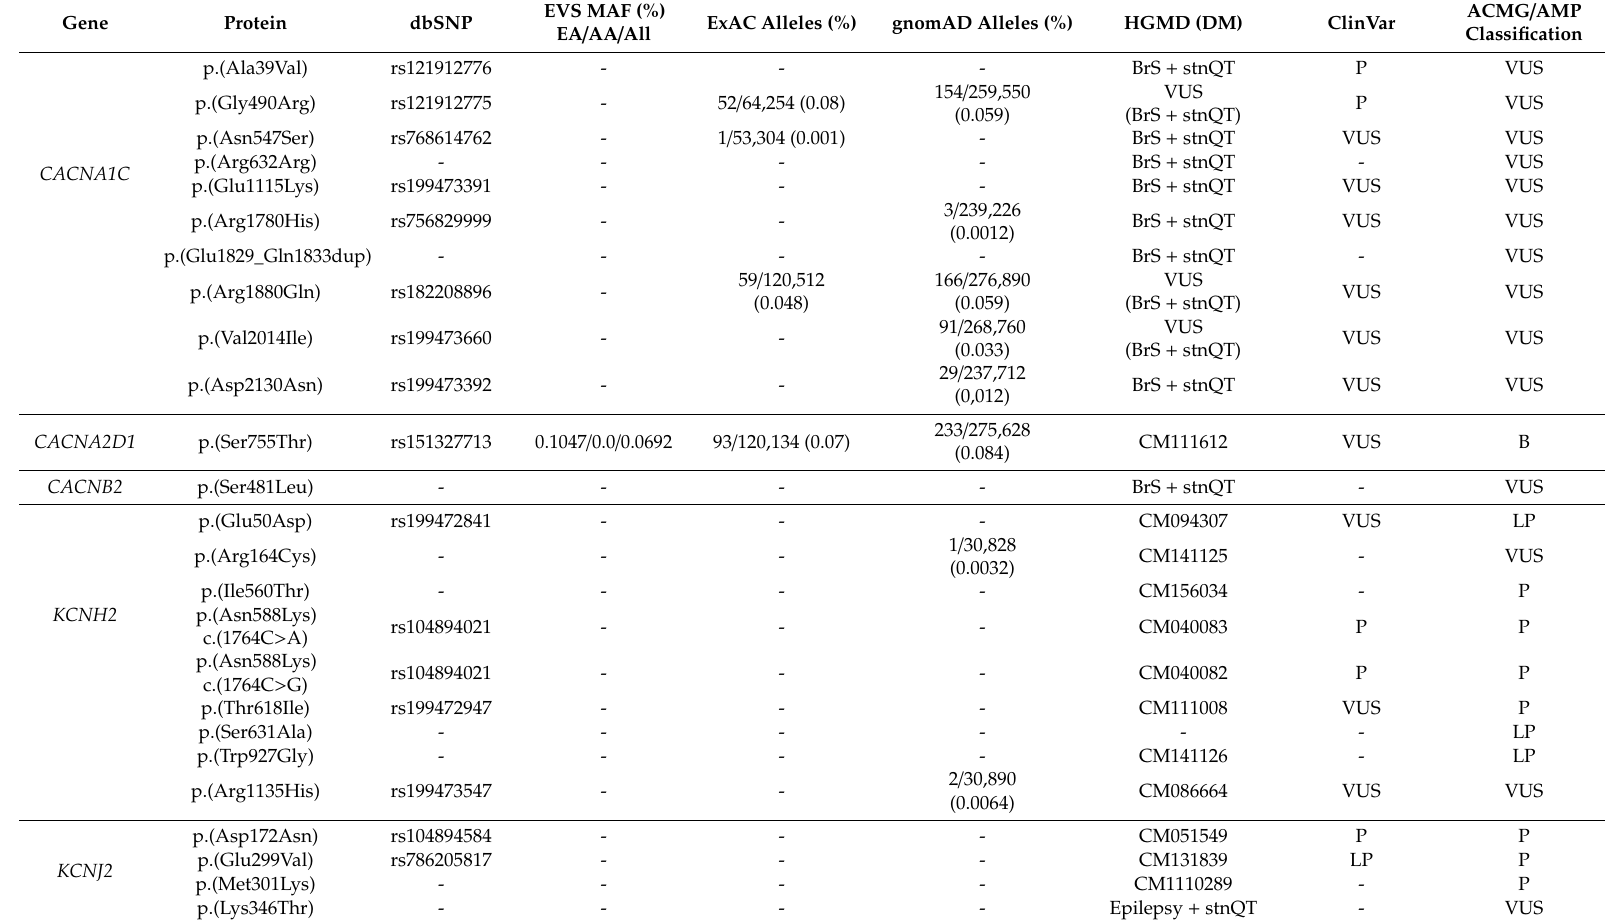
Table 1. Pathogenic and additional variants associated with Short QT